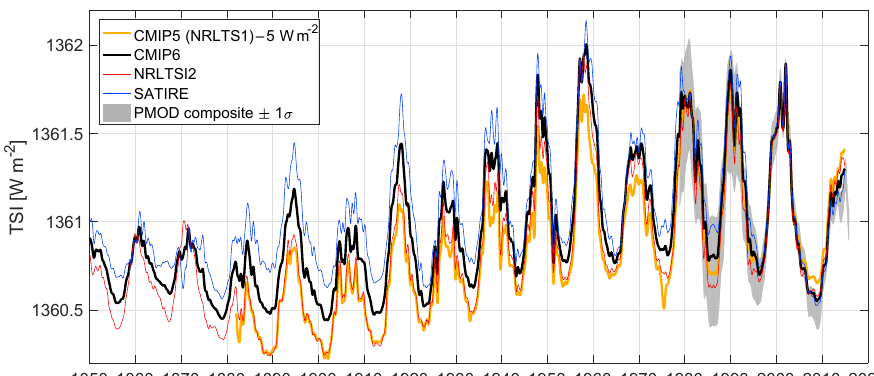
Figure 1. Comparison of several TSI reconstructions, showing 6-month running averages of the NRLTSI1 record (reference for CMIP5, and thus continuing after the 2010 end date of CMIP5), the CMIP6 composite, and the reconstructions from the NRLTSI2 and SATIRE models. Also shown is the observational composite from PMOD (version 42.64.1508) with a ± 1 σ confidence interval. A negative offset of −